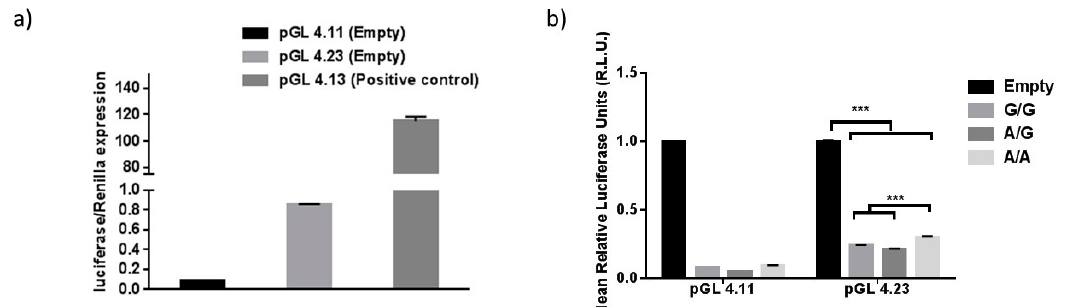
Figure 1. Luciferase Expression results for rs4977756 Genotypes. ( a ) Luciferase expression